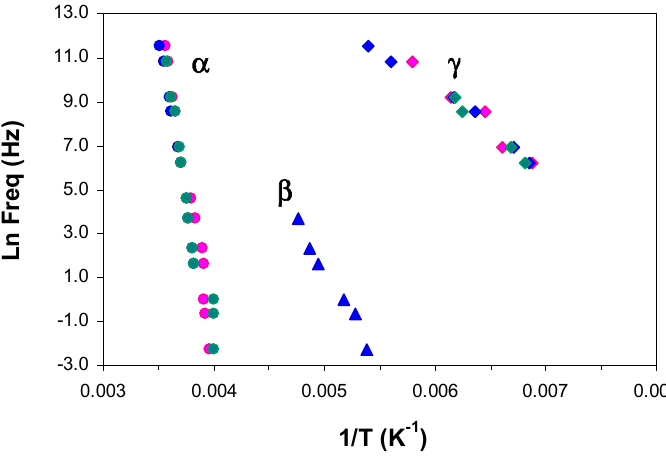
Figure 10. Relaxation map for ELP800 (blue), ELP2000 (green), and ELP25000 (pink) uncured systems at 0.5 °C/min: α -relaxation, circles; β -relaxation, triangles; γ -relaxation, rhombus.